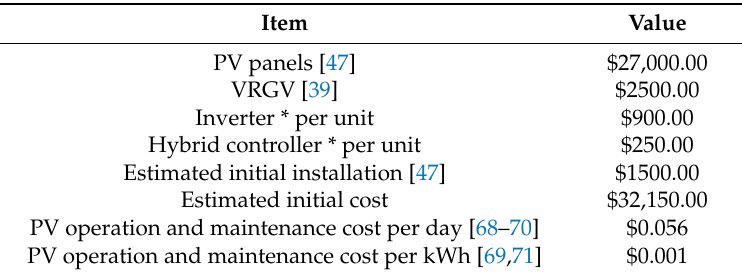
Table 7. Parameters of costs and maintenance of solar photovoltaic system.